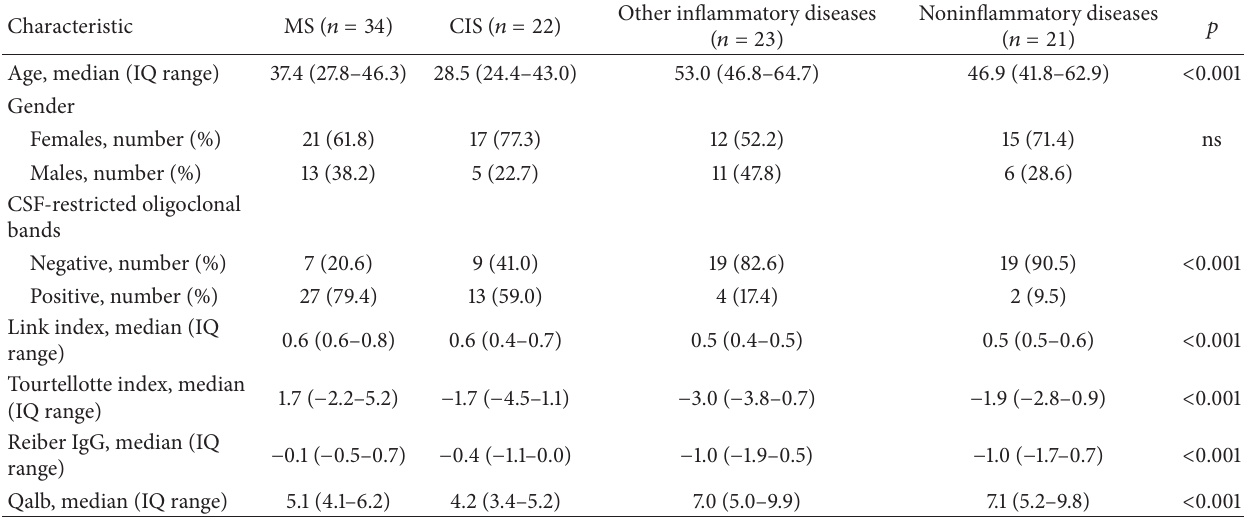
Table 2: Demographics and standard CSF characteristics of the patient groups.